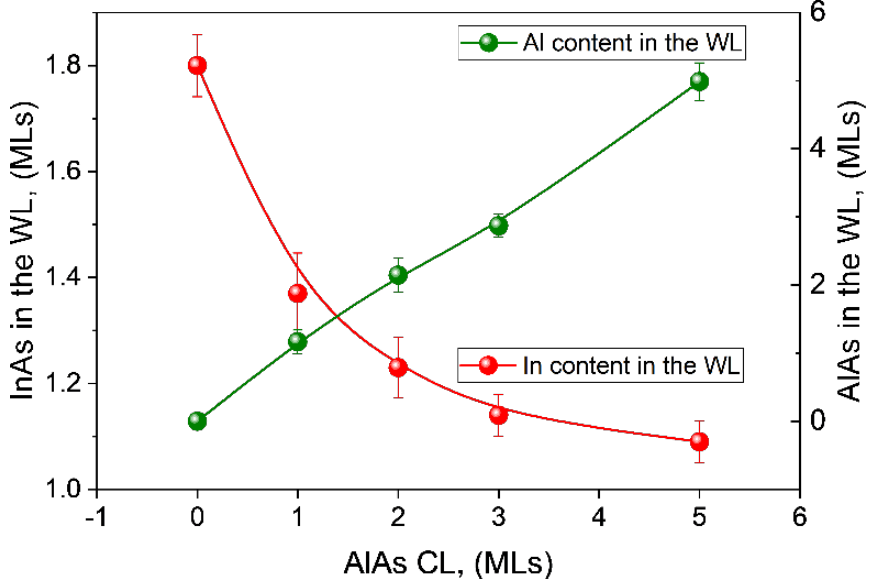
Figure 8. In and Al amount in the CL/WL regions expressed as deposited MLs. The results are obtained from the calibrations of the area in averaged profiles along the growth direction from EDX measurements in thin layers. Error bars shows the upper and lower 95% confidence limits using the standard error for the sample mean, multiplied by 1.96.